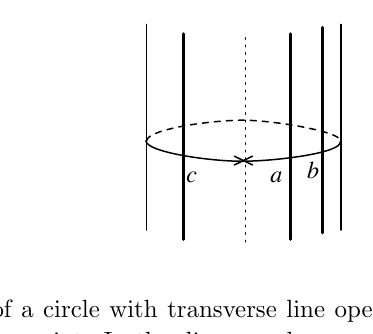
Figure 20 . An example of a circle with transverse line operators. The point marked with an X labels the choice of the base point. In the diagrams here and below, the time (cid:13)ows upwards, and the lines also carry arrows in the upward direction unless otherwise